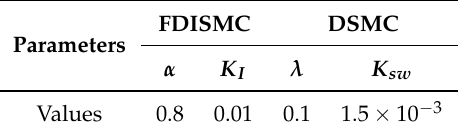
Table 3. Parameters of the discrete-time fractional order integral sliding mode control (DFISMC) and conventional DSMC